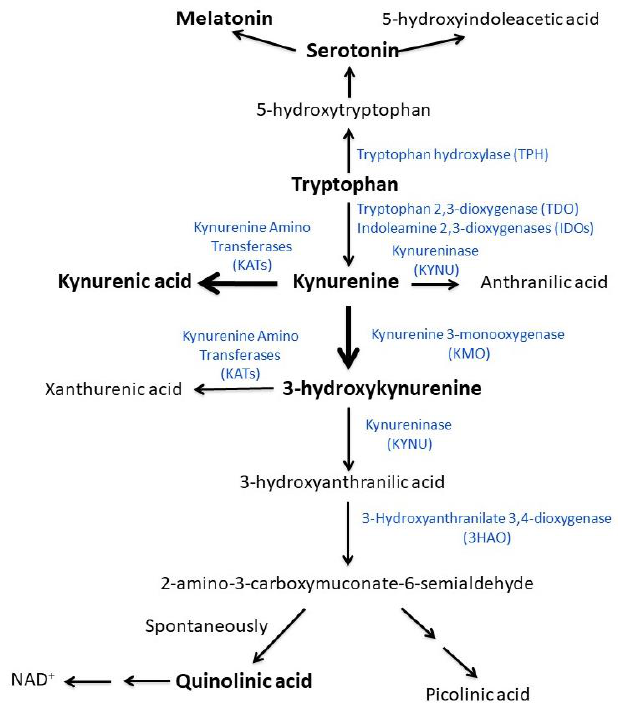
Figure 1. Schematic representation of the metabolism of tryptophan through the serotonin and kynurenine pathways. Enzymes involved in the different biochemical steps are indicated next to the arrow. Metabolites analyzed in this study are in bold.